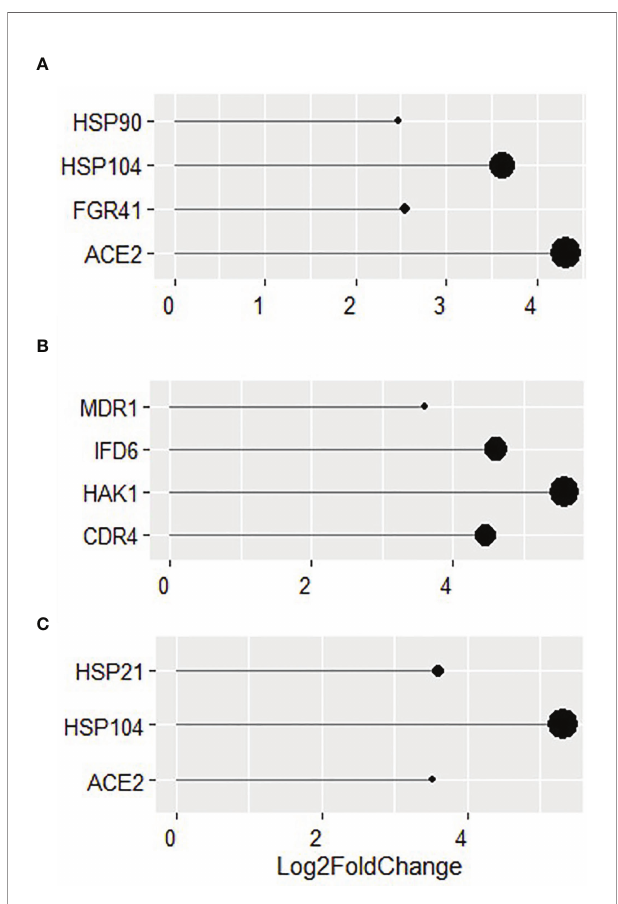
FIGURE 6 | Identi fi cation of key genes with increased expression in dual- species bio fi lms. Log 2 fold change of key genes in 24 h dual-species bio fi lms of (A) WT, (B) als3 D / D and (C) ece1 D / D C albicans with S. aureus